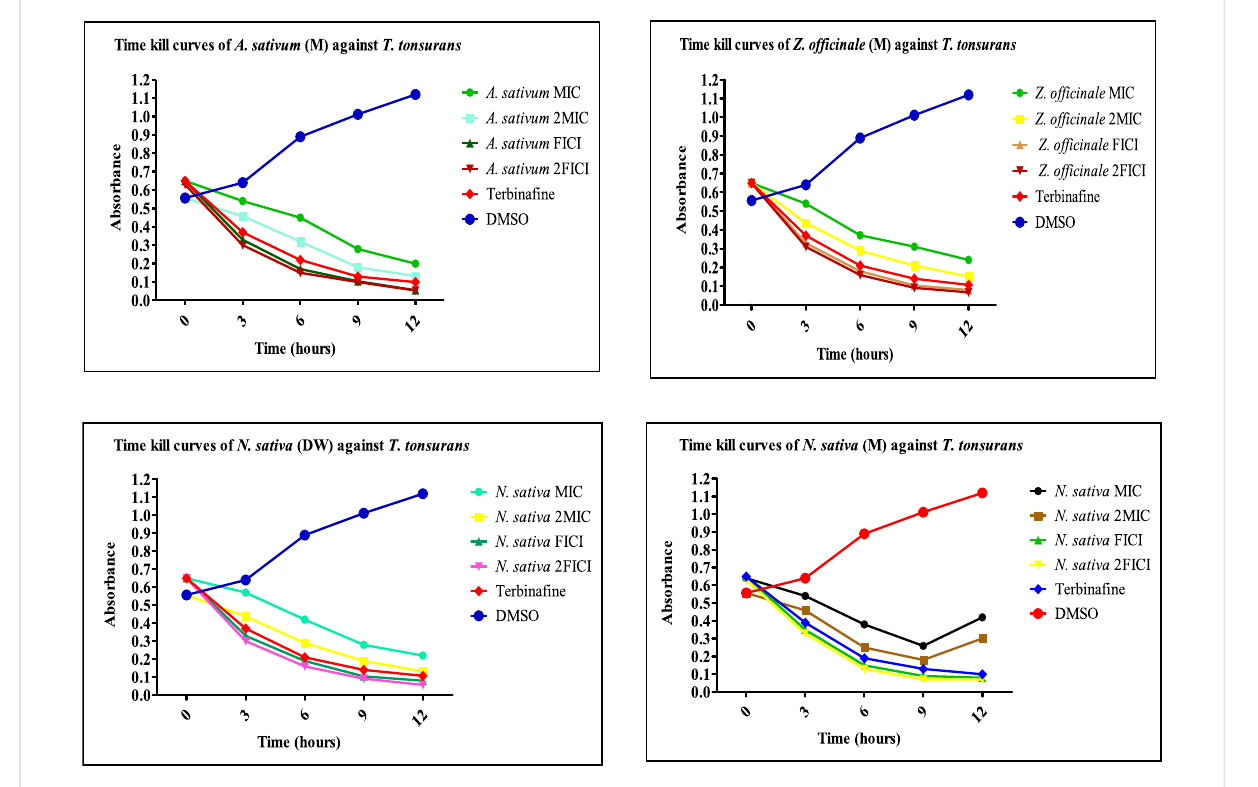
FIGURE 8 Time-kill curves of selected extracts against dermatophytes. M, methanolic extract; DW, distilled water